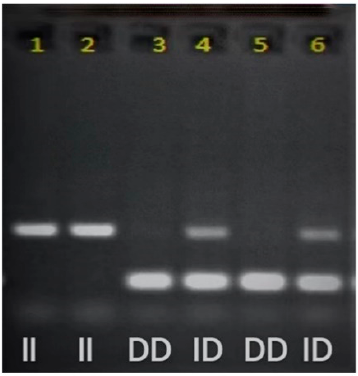
Figure 2. ACE polymorphism gene identification.